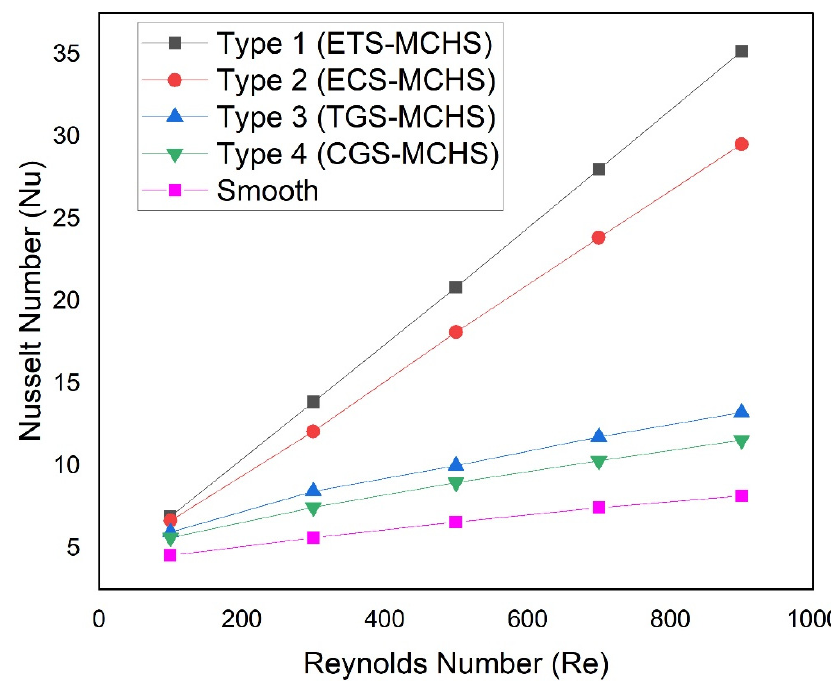
Figure 9. Plots of Nusselt number with Reynolds numbers for different design types.